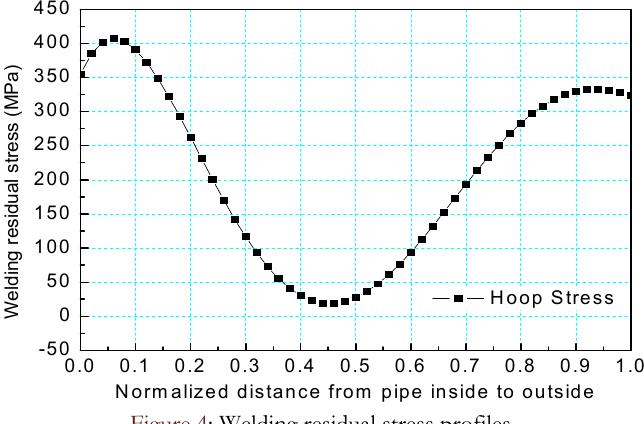
Figure 4: Welding residual stress profiles.